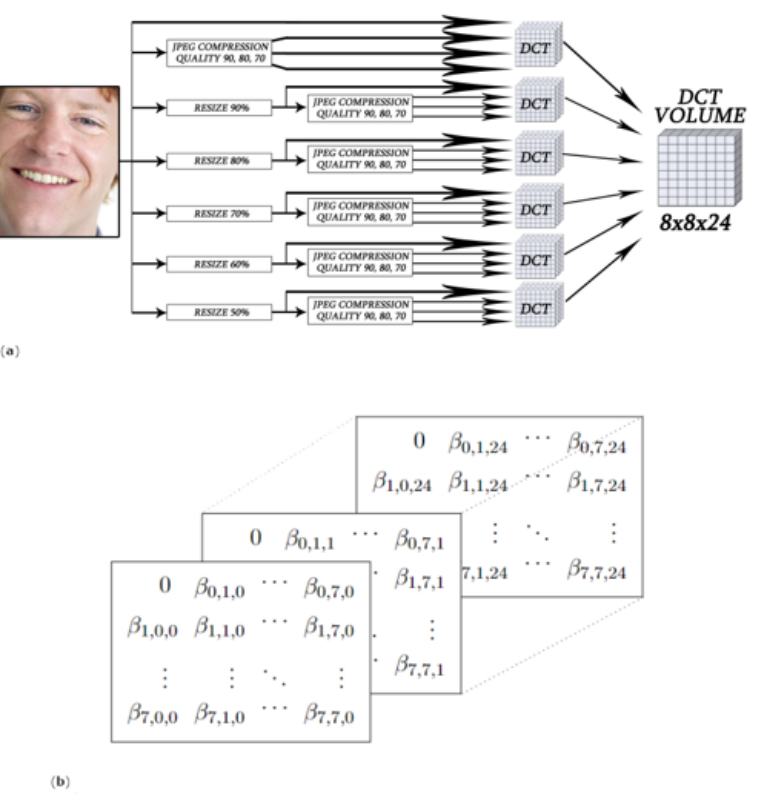
Figure 10. Construction of the representation used as input of the model, designed to be robust to resizing and compressions typical of Deepfakes exchanged on the web. General overview ( a ) and tensor representation ( b )